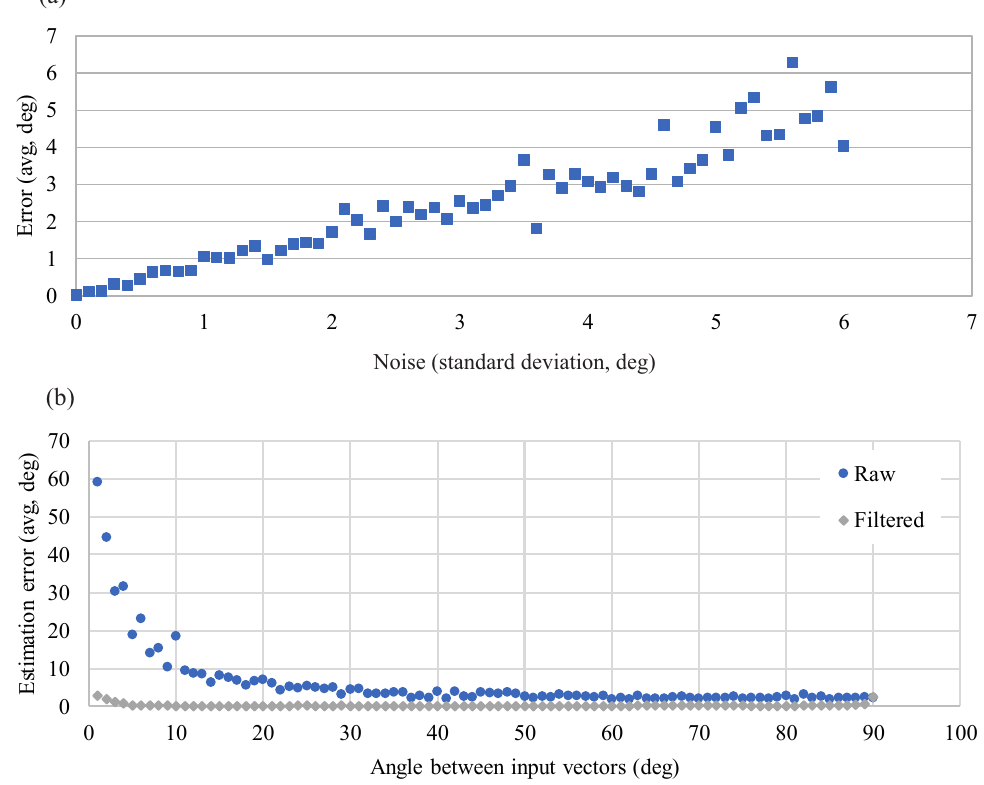
Fig. 7. (a) Attitude error measurement noise and (b) angle